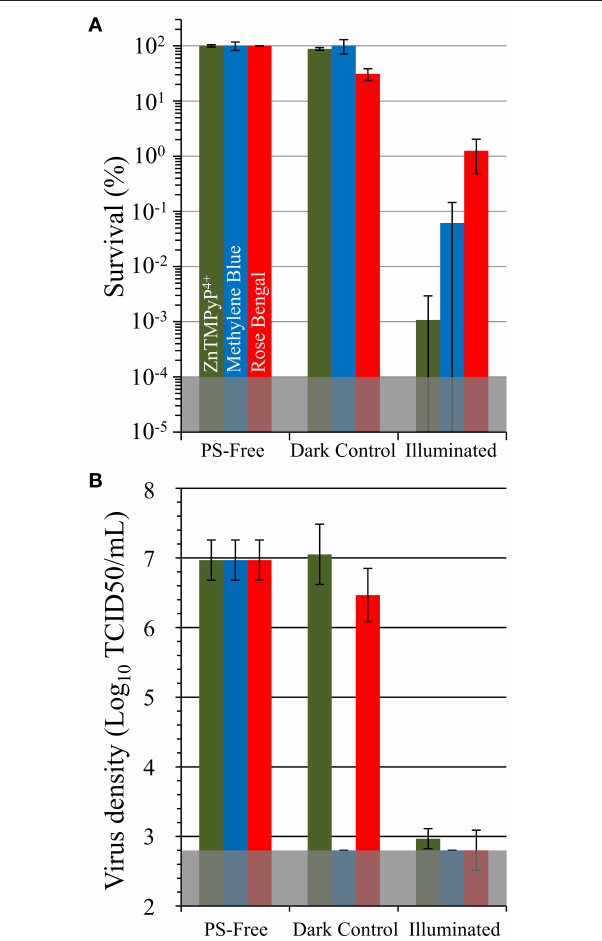
FIGURE 6 | Antimicrobial photodynamic inactivation efficacy of Vescom materials coated with SbQ-PVA/ZnTMPyP 4 + for (A) methicillin-susceptible S. aureus ATCC-29213 (MSSA) and (B) human coronavirus 229E (HCoV-229E). Assays were performed under fixed illumination conditions (60min, 400-700nm, 65 ± 5 mW/cm 2 ). The gray shaded regions represent the minimum detection limit for each study. Error bars correspond to the standard deviation ( n = 3).